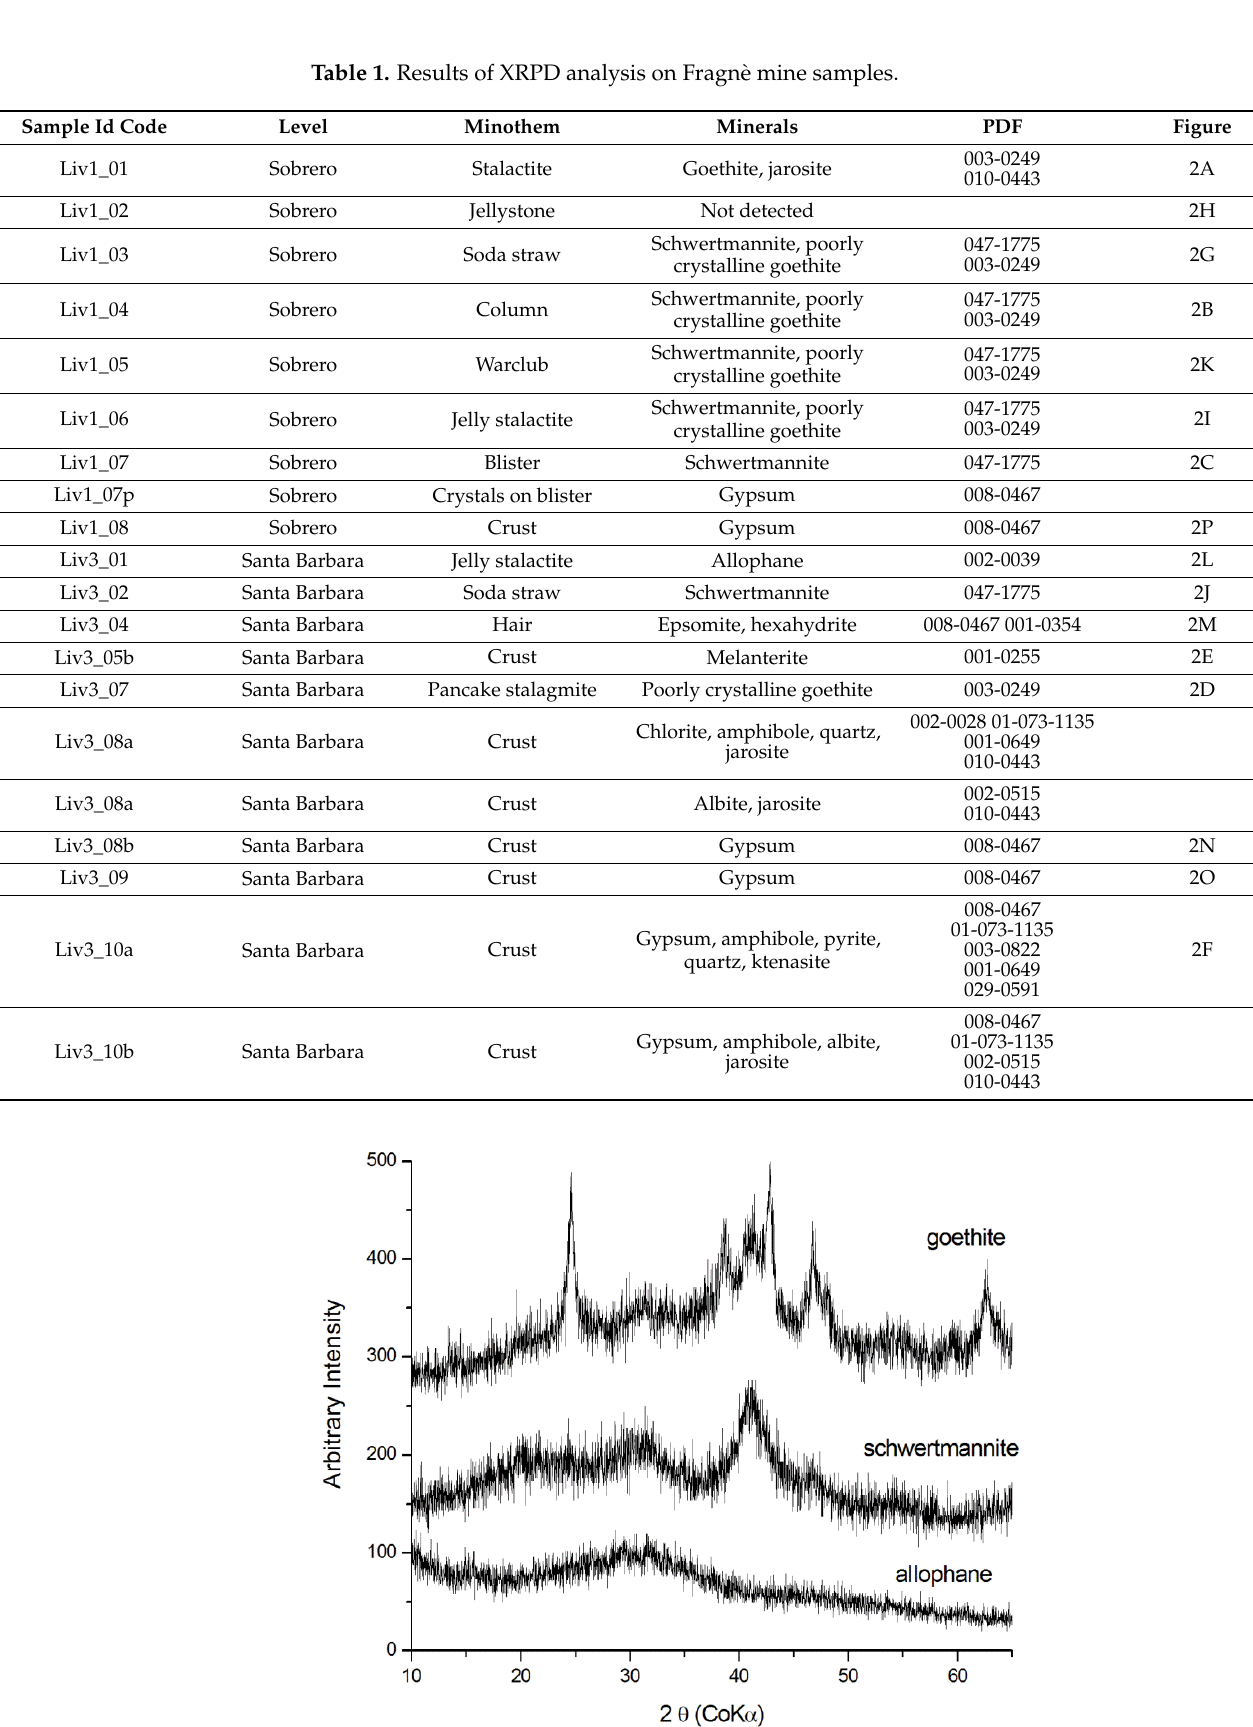
Figure 3. X-ray diffraction patterns of allophane, schwertmannite, and poorly crystalline goethite.